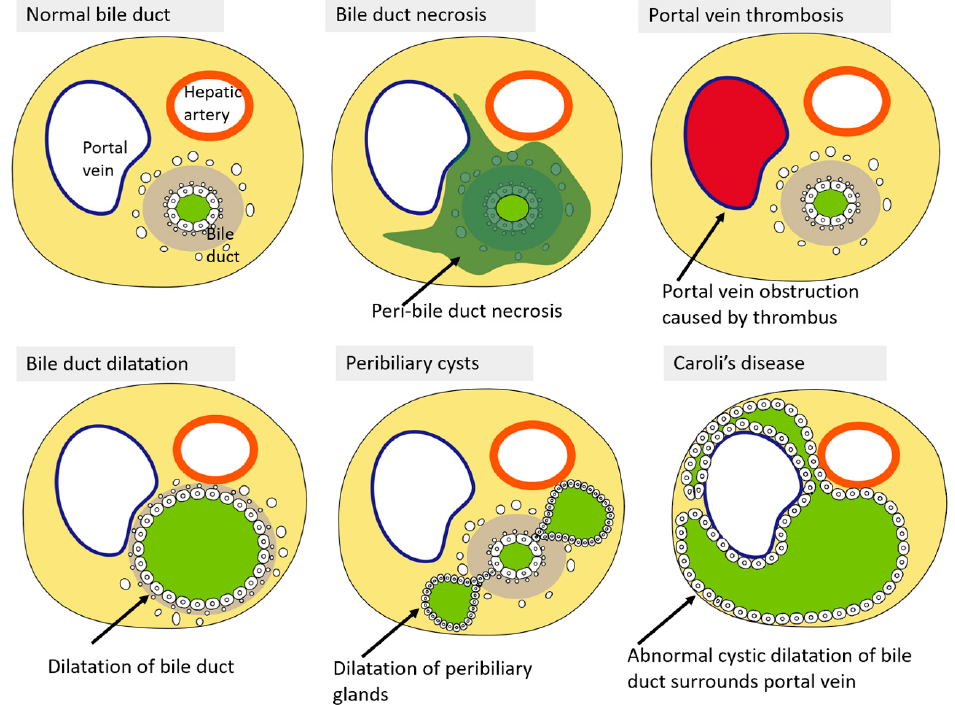
Figure 21. Schematic diagram of the pathological characteristics which show a hypodense tube-like structure on pre-contrast-enhanced CT and contrast-enhanced CT in BDN and its mimickers.